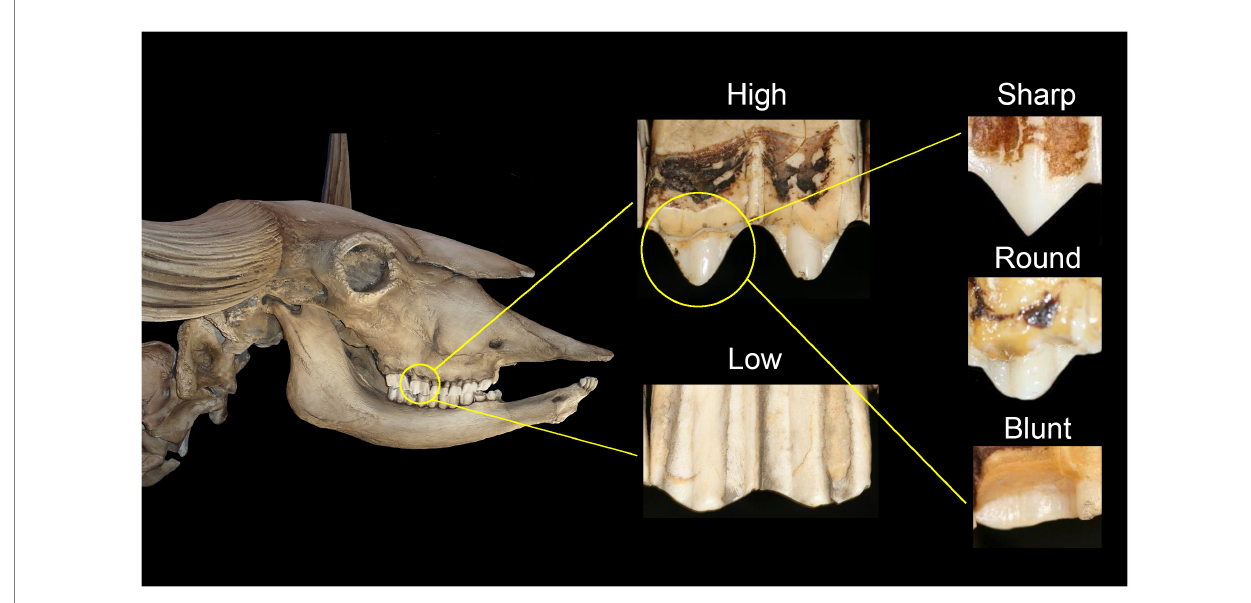
FIGURE 1 Traditional mesowear analysis uses a categorical approach to scoring cusp relief (high or low) and apical shape (sharp, round, or blunt). Browsing ungulates tend to have high and sharp cusp morphologies, whereas grazing ungulates tend to show low and blunt or rounded cusps, with mixed feeders showing intermediate